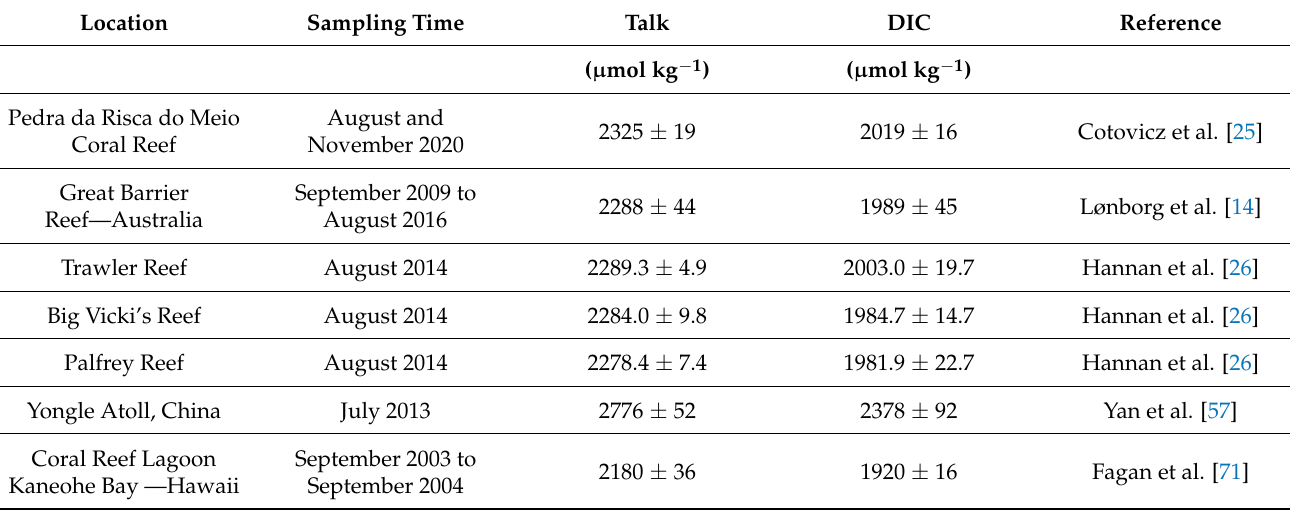
Table A1. Comparisons in the values of TAlk ( µ mol kg − 1 ) and DIC ( µ mol kg − 1 ) from some coral reef waters in the